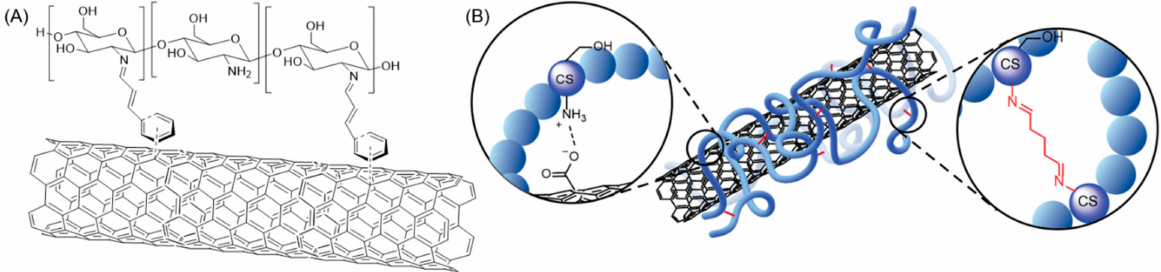
Figure 10. CNT and aryl–CS systems: ( A ) illustration of π – π stacking between a cinnamaldehyde-functionalized CS and a CNT. ( B ) Ionic interactions and interpenetration between a CNT displaying carboxylic acid moieties and a CS cross-linked with glutaraldehyde. Adapted from [145,146]. For visibility, the CS units not involved in the interaction are represented by a simple blue